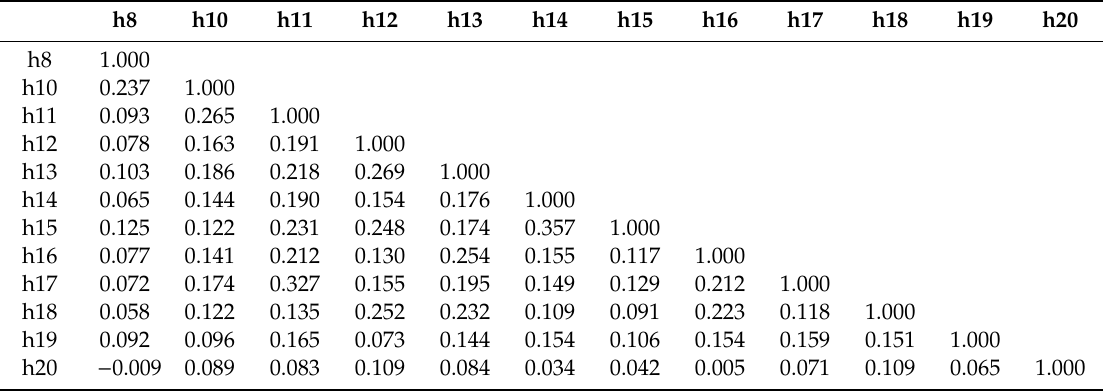
Table 4. Inter-item correlation matrix (clinical features of SARS-CoV-2 infection).